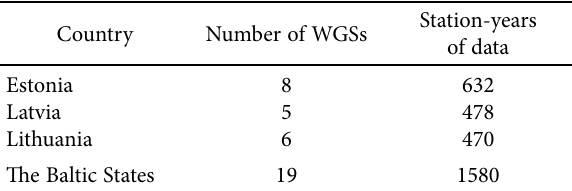
Table 1. Summary of the used data Country